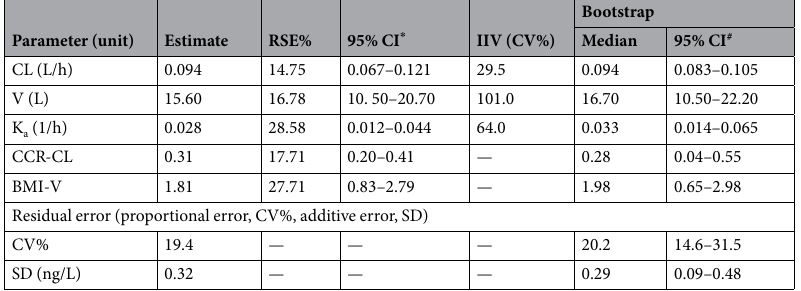
Table 2. The parameters of final population pharmacokinetic model. * The range was calculated by the equation estimate ± 1.96 SE. # 2.5th and 97.5th percentile of the ranked bootstrap parameter